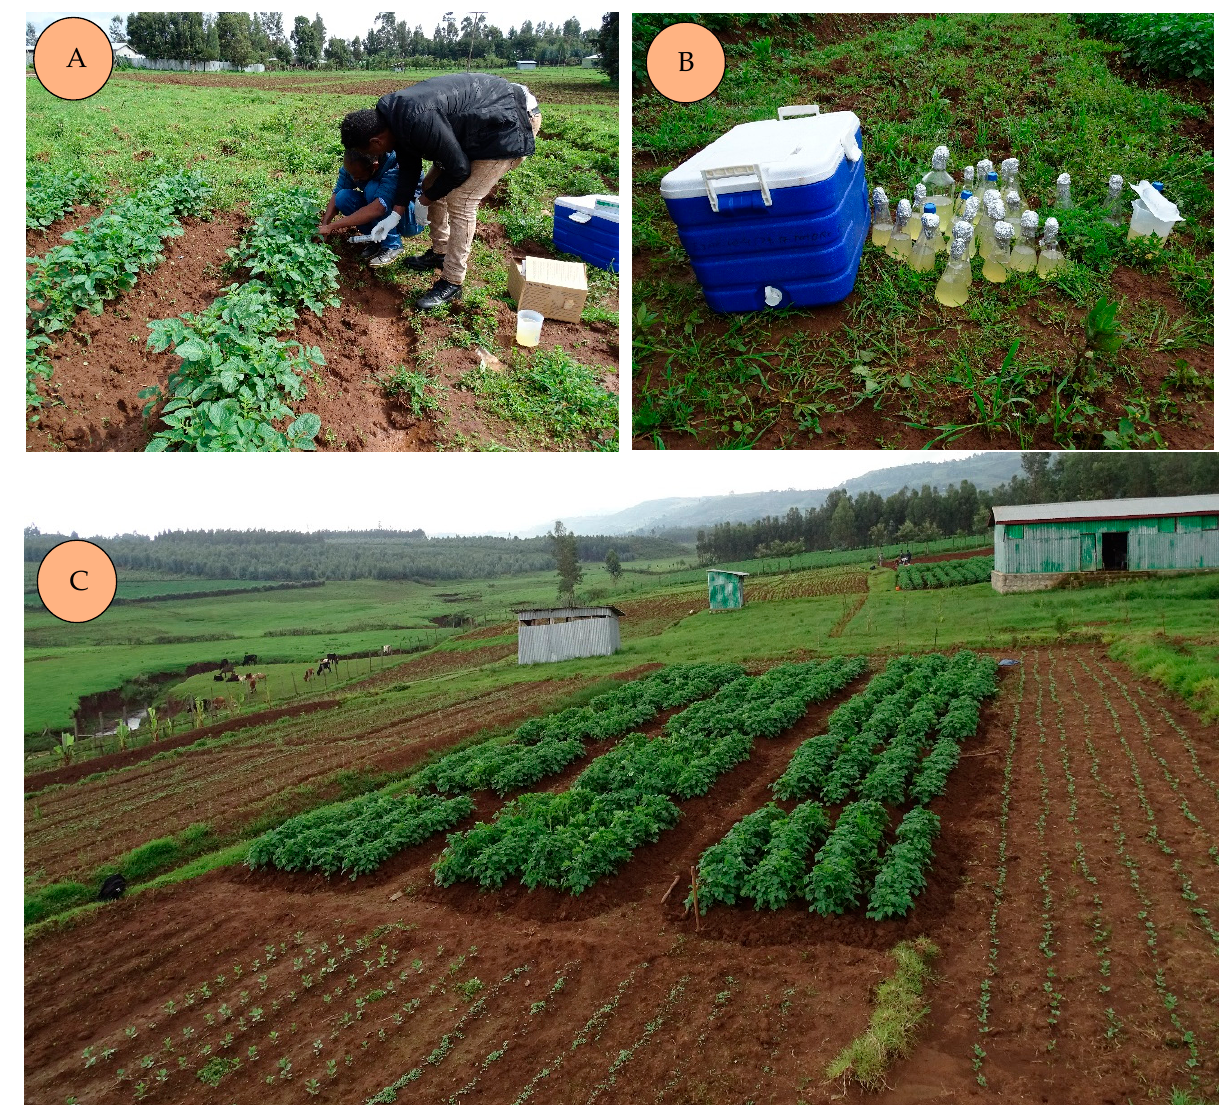
Figure 1. Field experiment. ( A ) Inoculation of each plant by drenching, ( B ) Bacterial suspension prepared for inoculation in Erlenmeyer flasks, and ( C ) Experimental plots at one of the sites (Wolmera Choke).